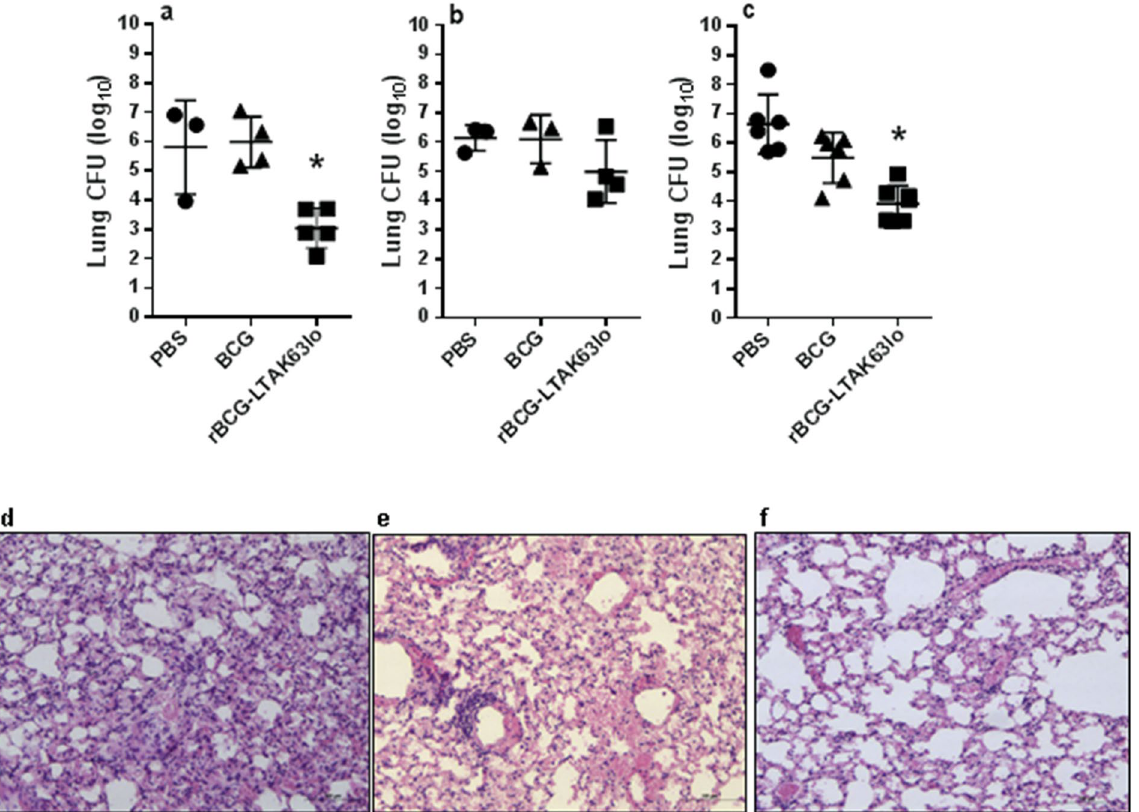
Figure 4. Immunization of mice with rBCG-LTAK63 lo induces protection against challenge with a higher dose of Mtb. BALB/c mice were immunized with BCG or rBCG-LTAK63 lo (1 × 10 6 CFU) and a group received PBS and challenged 12 weeks later with a high intratracheal dose of Mtb H37Rv (1 × 10 7 CFU). Bacteria were recovered from the lungs of challenged mice after ( a ) 30 days or ( b ) 60 days. In a second experiment under the same conditions bacteria were recovered from the lungs of challenged mice after c ) 120 days. ( * ) Differences were considered statistically significant when P ≤ 0.05 as compared to the BCG group (one-way